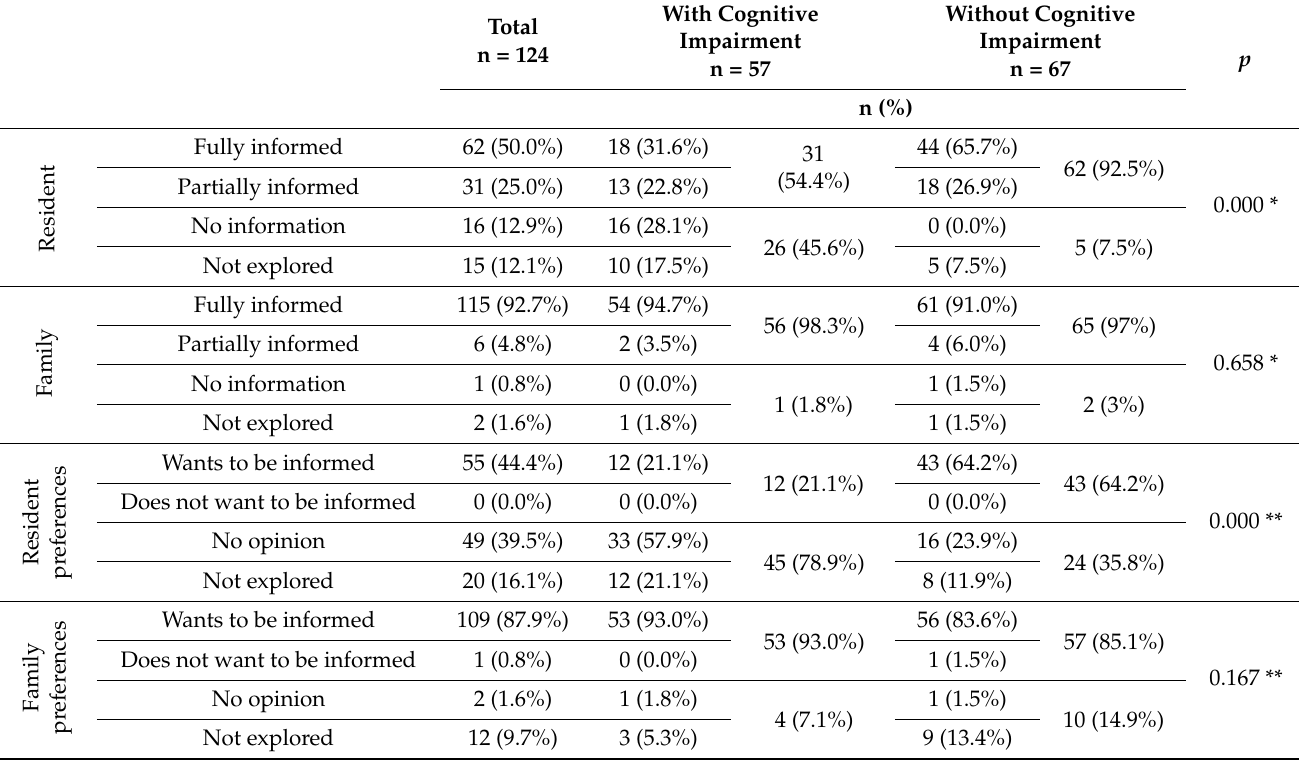
Table 1. Resident/family information levels and